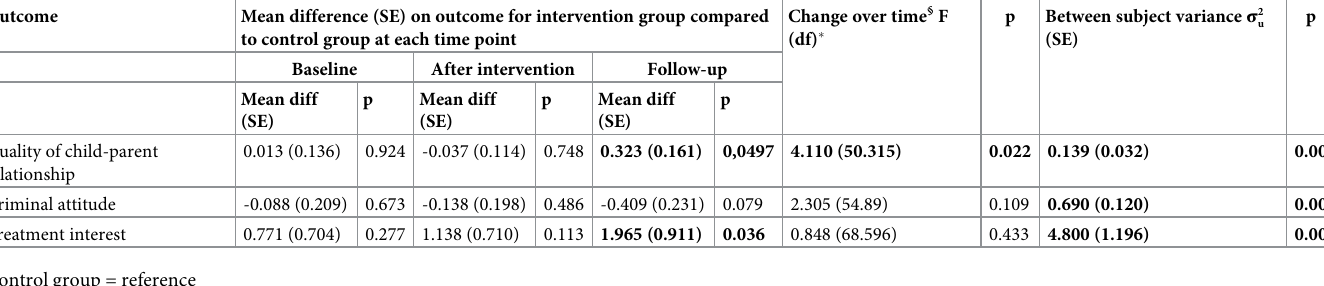
Table 2. Effect of intervention over time on primary and secondary outcomes in the intention-to-treat analysis. Estimates for the intervention group compared to the control group between each time point, and change over time. Outcome Mean difference (SE) on outcome for intervention group compared to control group at each time